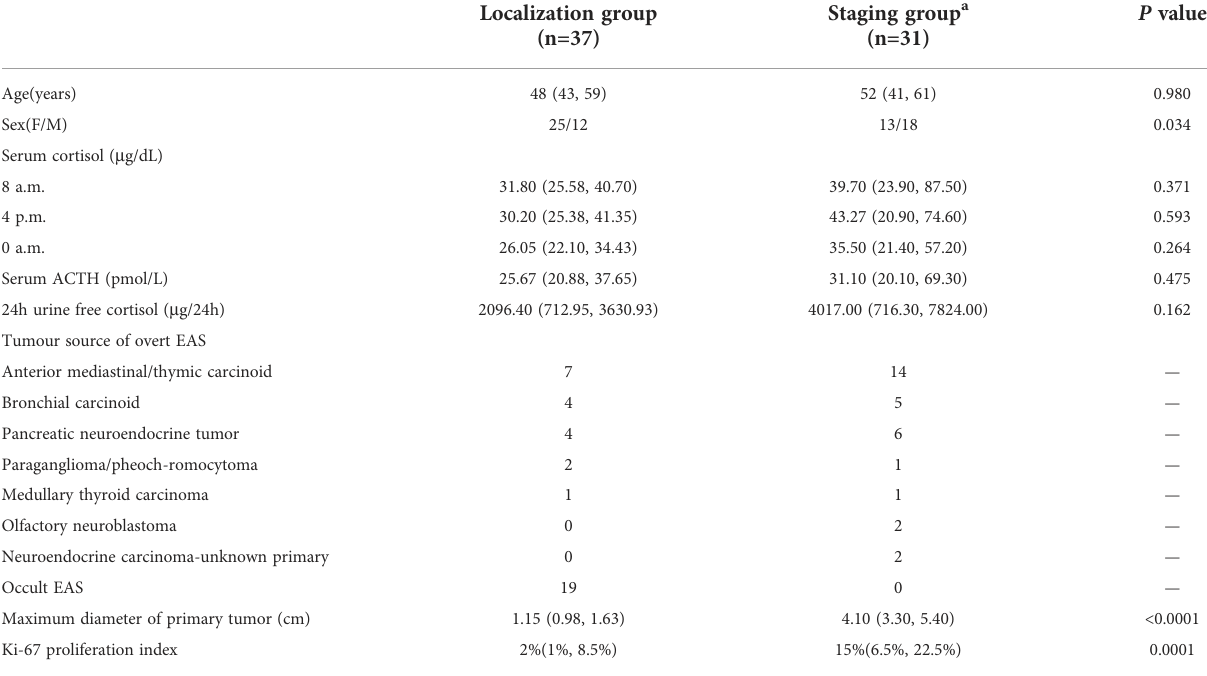
TABLE 1 Demographics, laboratory data, fi nal diagnosis and tumor characteristics for ectopic ACTH syndrome